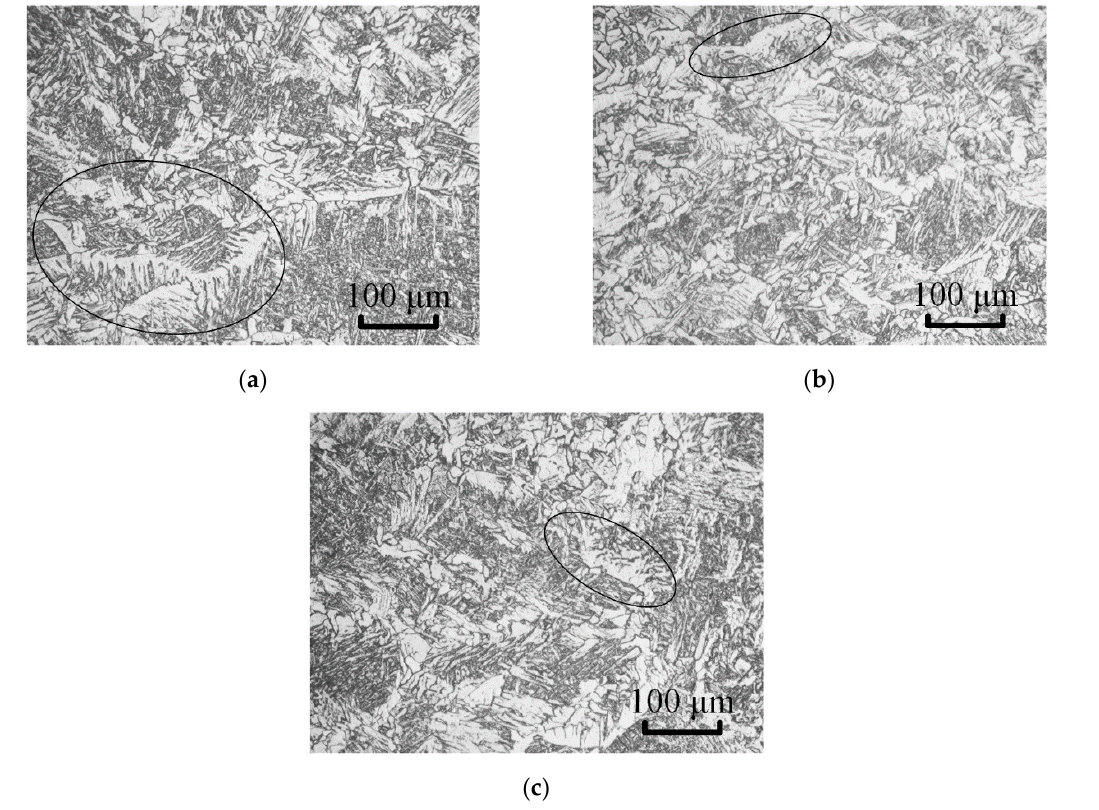
Figure 5. Optical microstructures of weld metal with three typical modes of droplet transfer: ( a ) one drop per multiple pulses (ODMP); ( b ) one drop per pulse (ODPP); ( c ) multiple drops per pulse (MDPP).